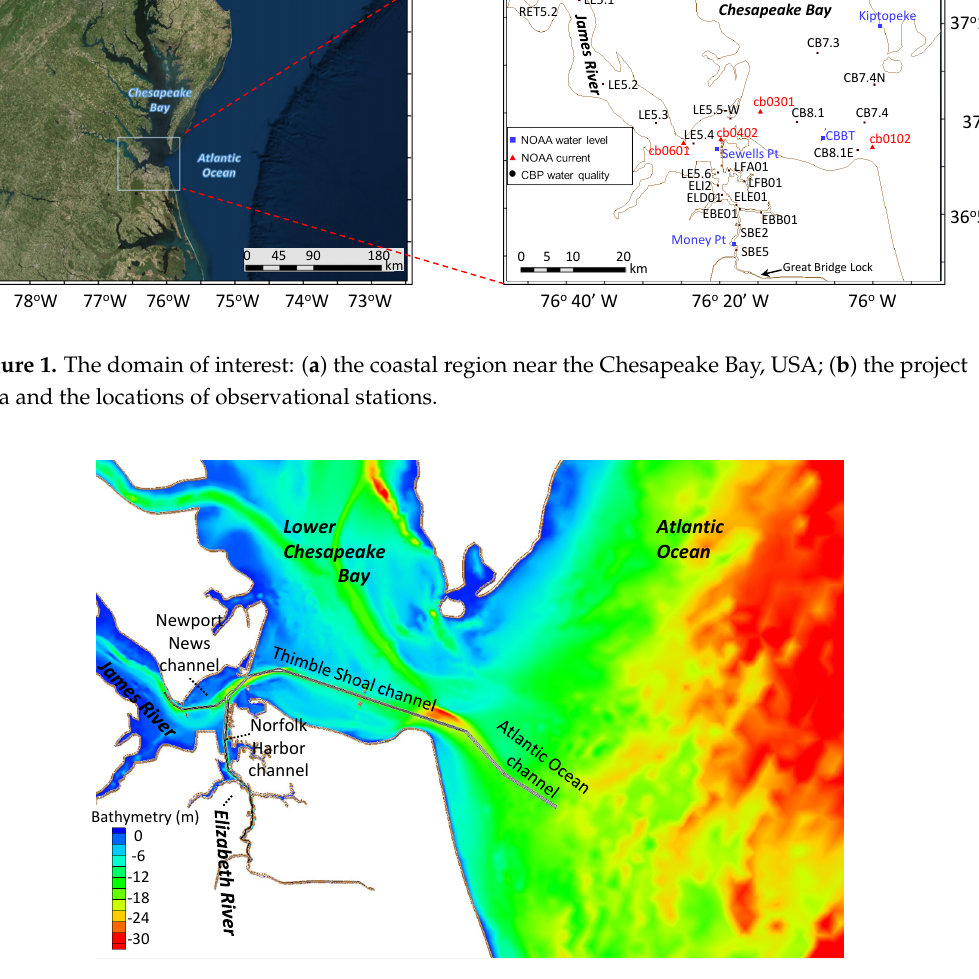
Figure 2. The bathymetry of the project area, with artificially maintained shipping channels delineated by solid black